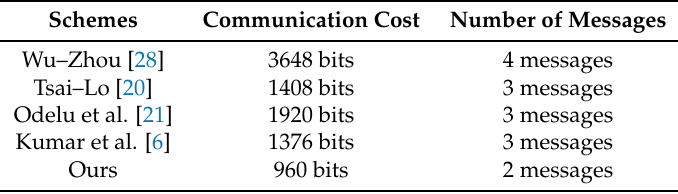
Table 7. A comparative summary: communication overheads.